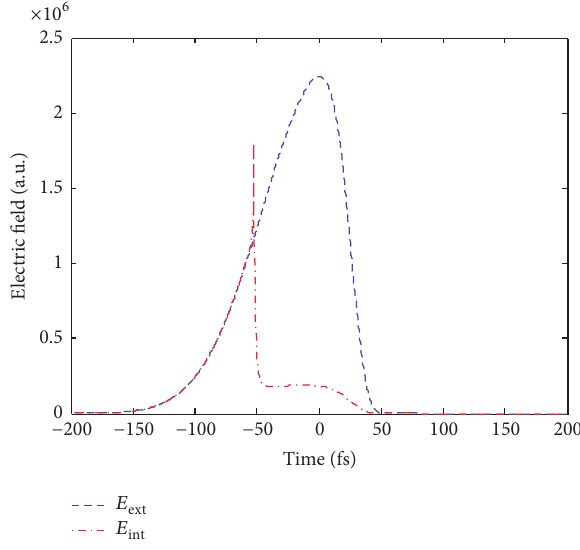
Figure 1: The electric field inside the cluster and external negatively chirped laser pulse field with 40fs duration pulse, 6 × 10 14 Wcm −2 laser intensity, and 825 nm